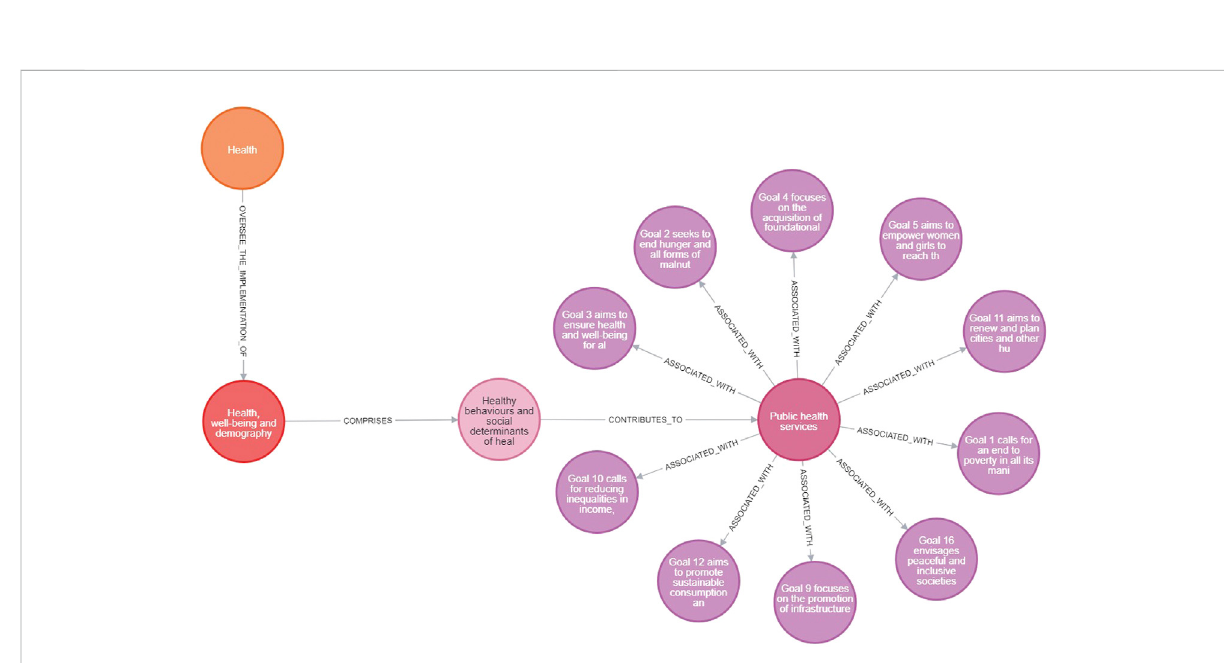
FIGURE 11 Association between a speci fi c Transformation and the